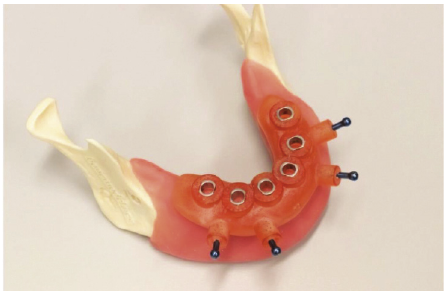
Figure 2: Printed surgical guide for a full mouth rehabilitation using four guide pins [34].